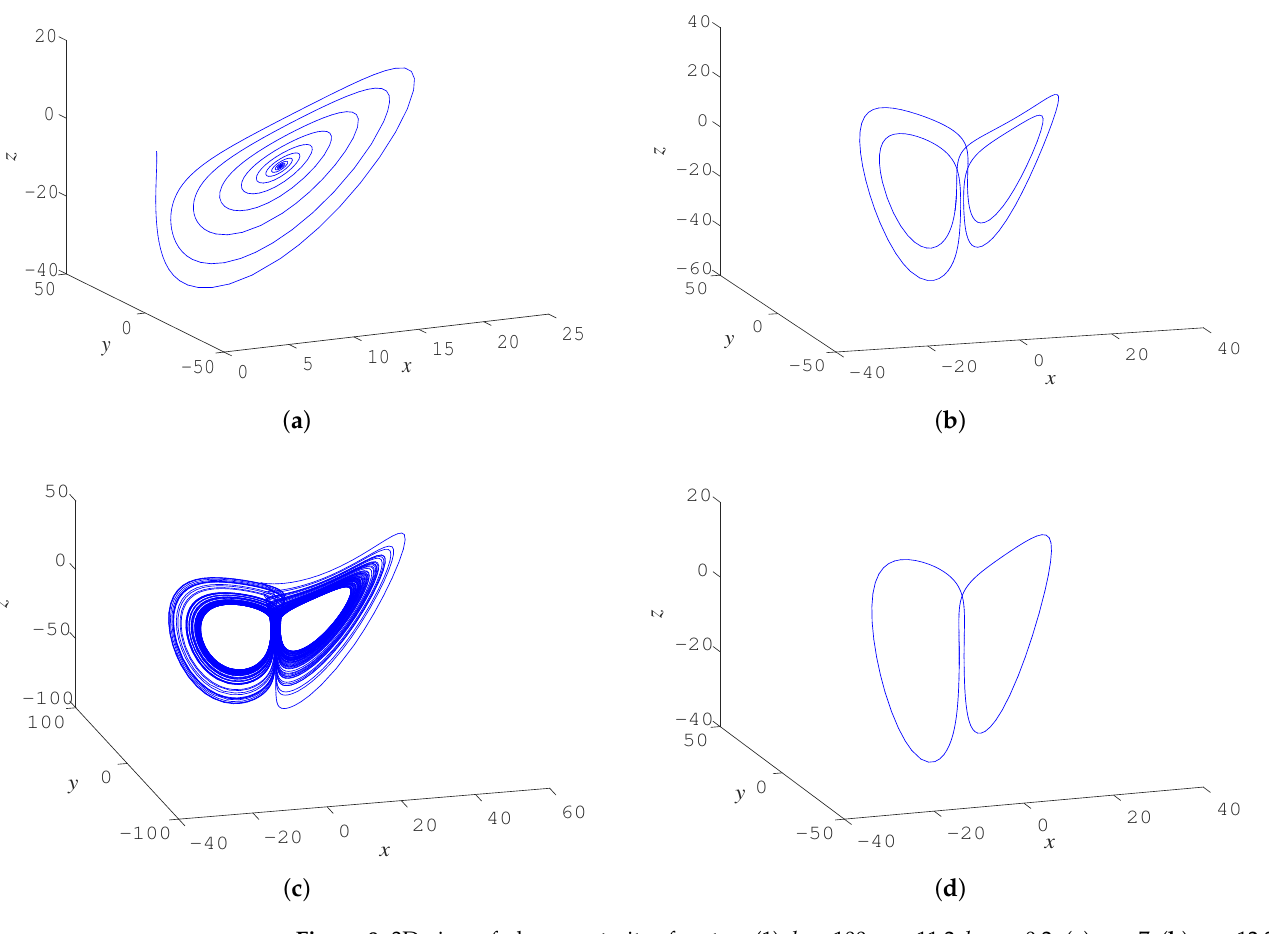
Figure 8. 3D view of phase portraits of system (1), b = 100, c = 11.2, k = − 0.2: ( a ) a = 7; ( b ) a = 12.2; ( c ) a = 13; ( d ) a =